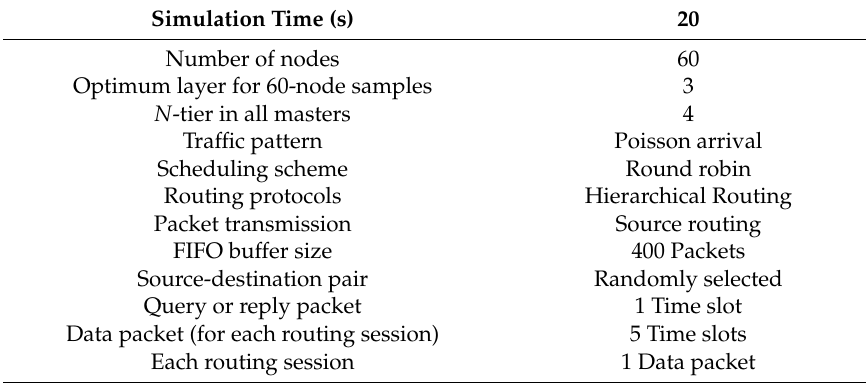
Table 1. The simulation parameters.